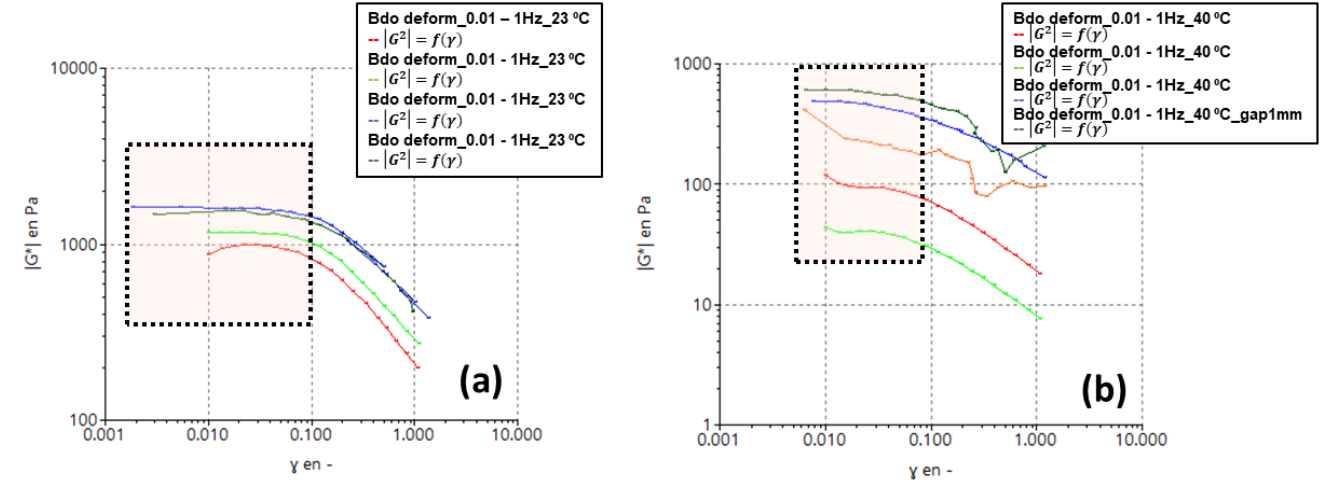
Figure 1. Strain sweeps at different frequencies to determine the linear viscoelastic region of a 2% wt sample (shaded area) at the initial and final test temperature: ( a ) 23 °C and ( b ) 40 °C . To ensure that there was no denaturation of the protein during the rheological tests, a temperature sweep was performed on the samples, setting a test frequency within the linear viscoelastic region. In Figure 2, an example of the estimation of the T d (denaturation temperature) is presented. For the temperature sweep, the viscosity (red curve) and the tan δ (black curve), which is the quotient of the loss modulus between the storage modulus ( G ″ /G ′ ), were plotted. As shown in Figure 2, there were two ways to establish the T d of the samples. The first was to identify at which temperature the viscosity decreased by about 50% of its initial value; the second was to identify at which temperature the tan δ value reached a maximum. Table 2 shows the T d for all of the samples studied.